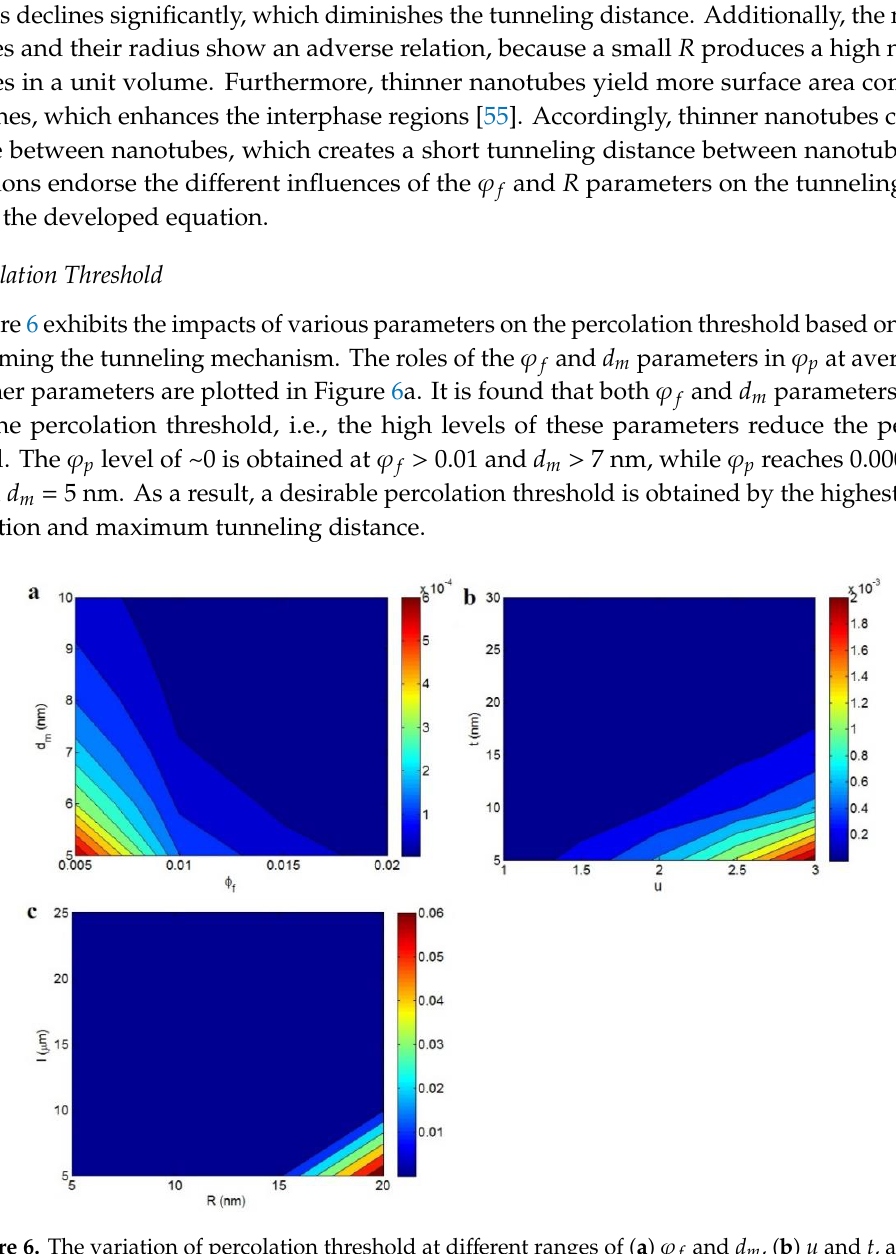
Figure 6. The variation of percolation threshold at di ff erent ranges of ( a ) ϕ f and d m , ( b ) u and t , and ( c ) R and l parameters.